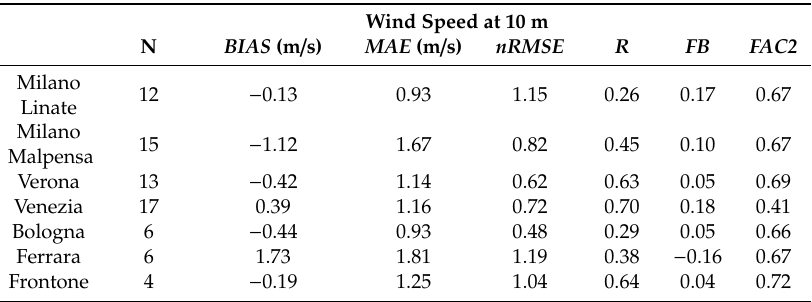
Table 5. Statistical scores of WRF wind speed at 10 m outputs of the seven selected sites. (a negative BIAS means a WRF underestimation and vice